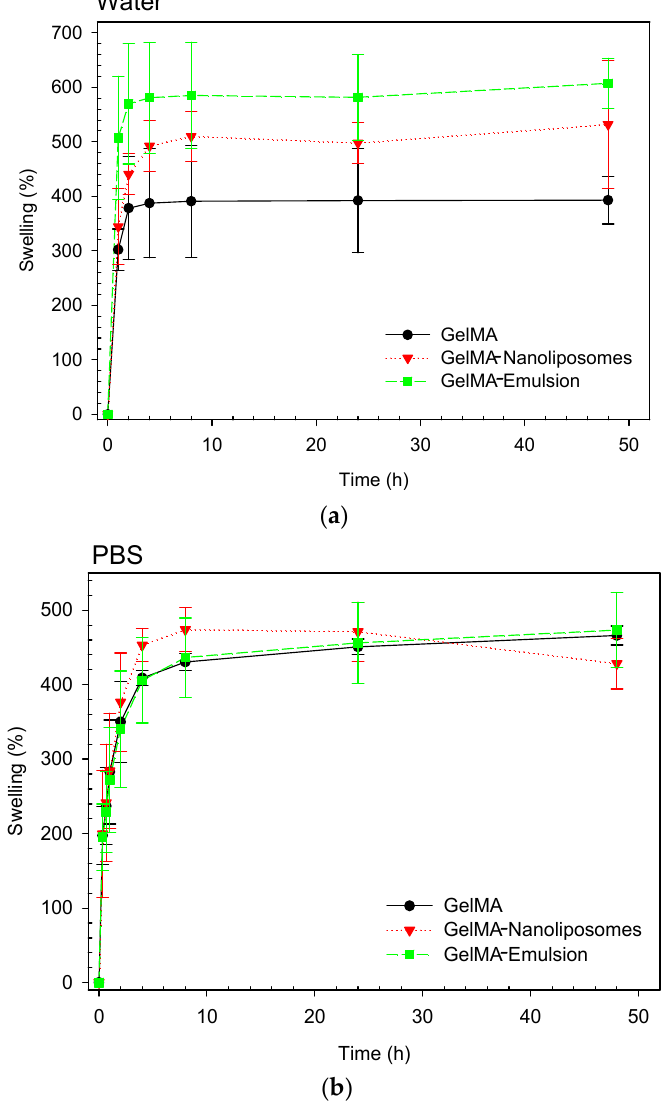
Figure 5. Degree of swelling of based hydrogels (GelMA ( ● ), GelMA-Nanoliposomes ( ▼ ), and GelMA-Emulsion ( ■ )) in two different solvents (a: deionized water and b: PBS solution), at 37 °C. Error bars represent standard deviation.